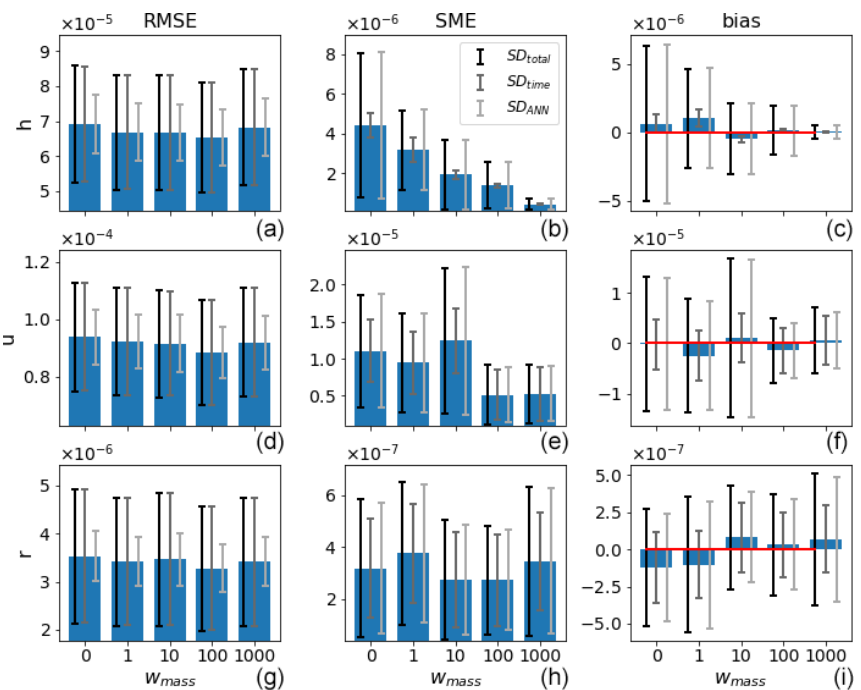
Figure 7. The RMSE (a, d, g) , MSE (b, e, h) , and bias (c, f, i) of the validation data for the different weightings ( x axis) and the respective model variables (rows) for the regular case. Error bars indicate (from dark to light) SD total , SD time , and SD ANN , and the red lines in the right panel indicate the zero line.